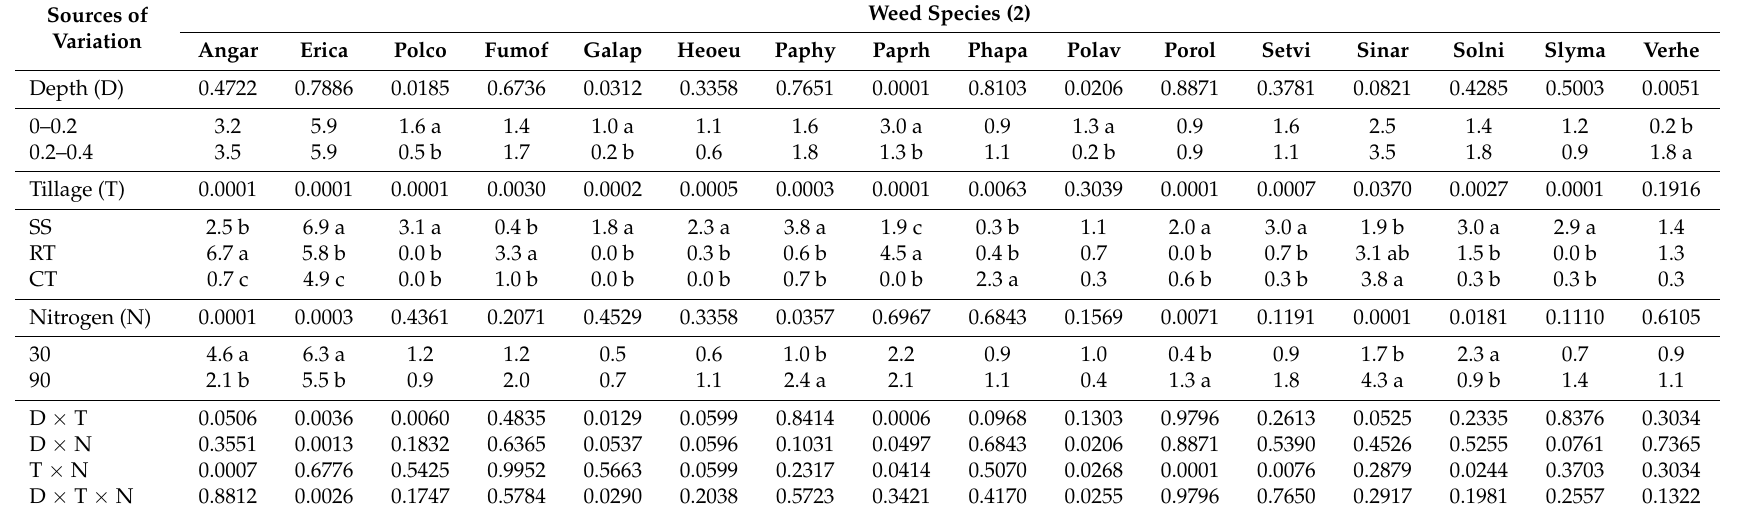
Table 5. Effect of soil depth (D, m), tillage system (T), and nitrogen supply (N, Kgha − 1 ) on weed seed bank composition